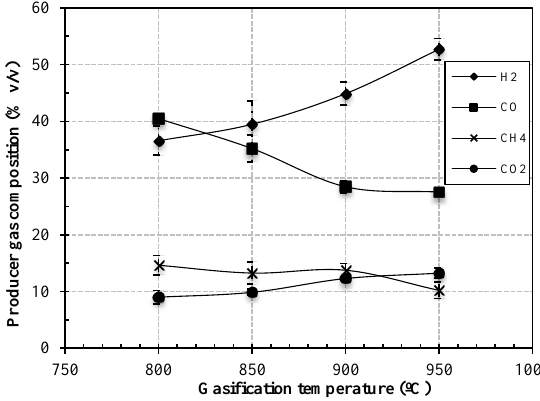
Figure 2. E ff ect of gasification temperature on producer gas composition. Figure 2. Effect of gasification temperature on producer gas composition. Figure 2. Effect of gasification temperature on producer gas composition.